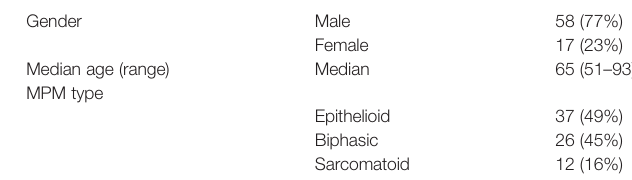
TABLE 1 | Mesothelioma patient